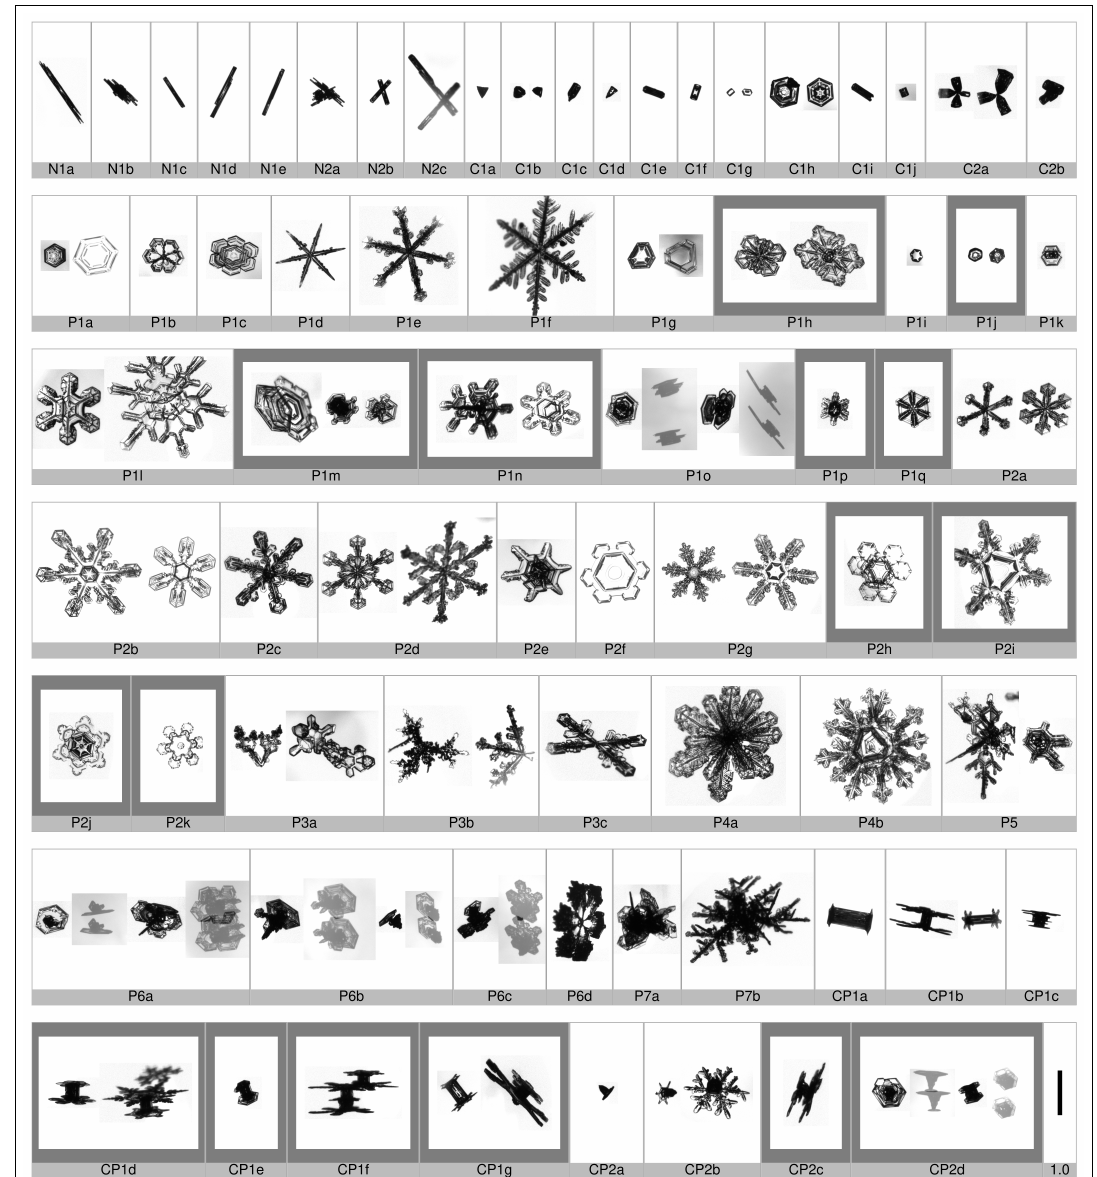
Figure A1. Updated shape classification (part 1): The 34 new shapes found in Kiruna are highlighted by thick gray frames. A list with the complete names of these shapes is shown in Table A1. Same scaling for all images: 1.0-mm scale bar is